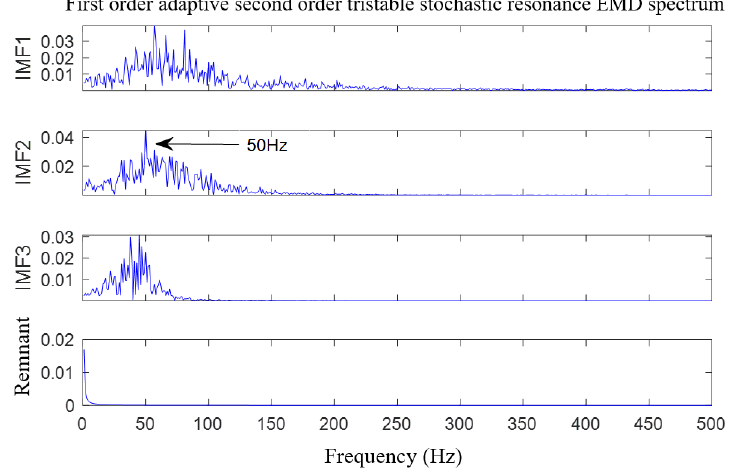
Figure 10. The processing results of the first-order stochastic resonance output.